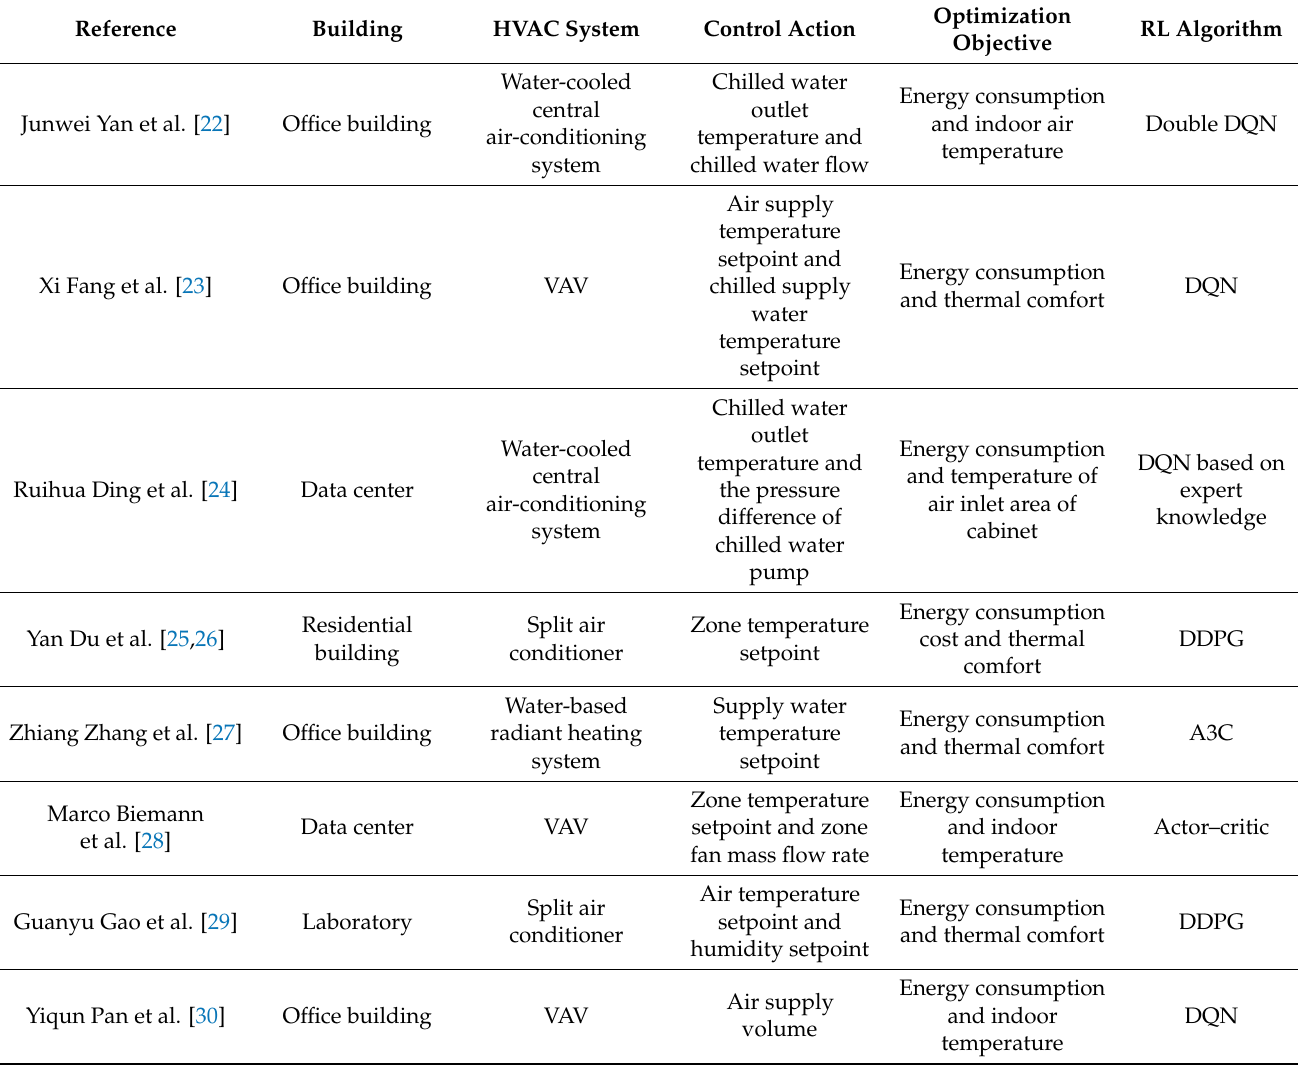
Table 1. Summary of the RL algorithm for optimal control of HVAC